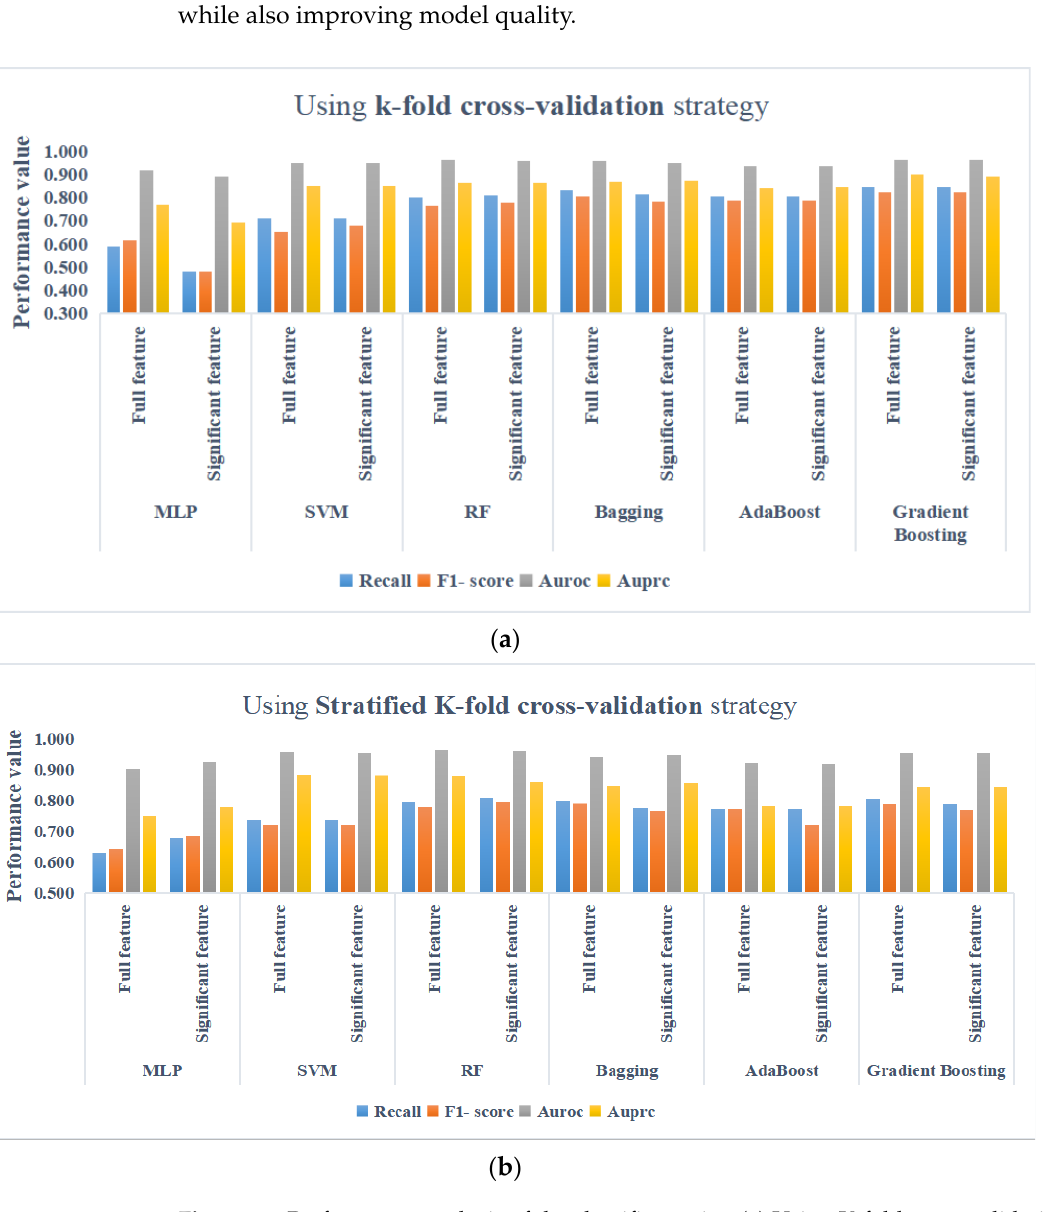
Figure 10. Performance analysis of the classifiers using ( a ) Using K-fold cross-validation strategy; ( b ) Using stratified K-fold cross-validation strategy.